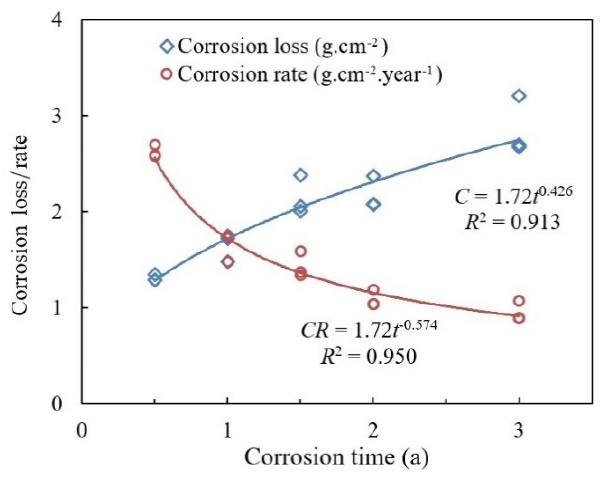
Figure 2. The relationship between corrosion loss/rate and corrosion time.